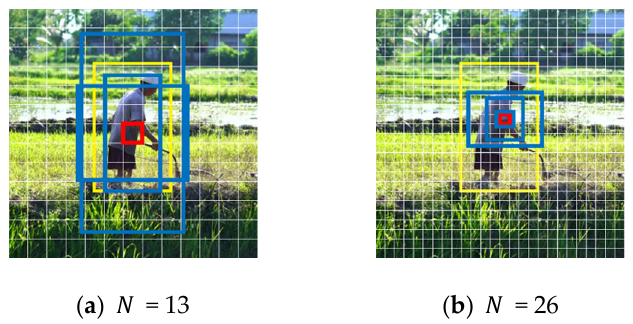
Figure 5. Sized grid at different scales. The blue boxes are the priori boxes obtained by clustering, the yellow one stands for ground truth, and the red one is the grid where the center point of object locates in.